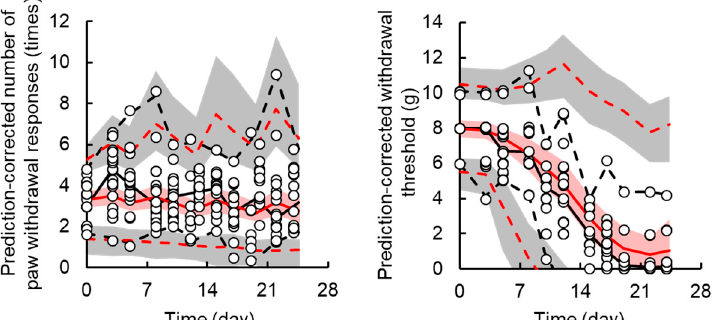
Figure 3. Prediction-corrected visual predictive check plot for the final pharmacokinetic-toxicodynamic (PK-TD) model of oxaliplatin (L-OHP)-induced acute (the left panel ) and chronic (the right panel ) neuropathy in rats. The solid black and red line represents the median observed and simulated prediction-corrected plasma concentration, respectively, and the semitransparent red field represents a simulation-based 95% confidence interval for the median. The observed and simulated 5% and 95% percentiles are presented with dashed black and red lines, respectively, and the 95% confidence intervals for the corresponding model predicted percentiles are shown as semitransparent gray fields. The observed prediction-corrected number of paw withdrawal responses in the acetone test and paw withdrawal threshold in the von Frey filament test are represented by circles. Table 2. PD parameters of acute and chronic neuropathy after administration of L-OHP in rats.